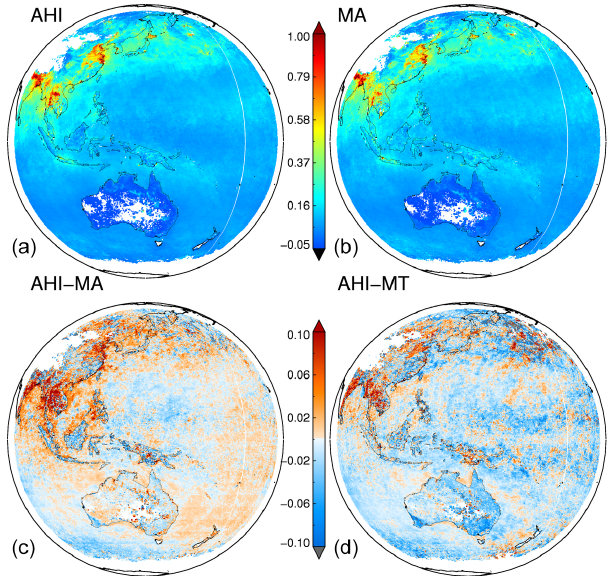
Figure 6. (a, b) Mean AOD at 550nm over the 2-month study pe- riod of May–June 2016. (a) Mean AOD derived from retrievals us- ing the new DT AHI algorithm applied to AHI. (d) Mean AOD de- rived from the standard Aqua MODIS DT product. (c, d) Difference maps of mean AOD at 550. (c) Difference between the two maps in (a, b) . (b) Similar difference map but between AOD from AHI and AOD from Terra MODIS (MT), instead of Aqua MODIS (MA).